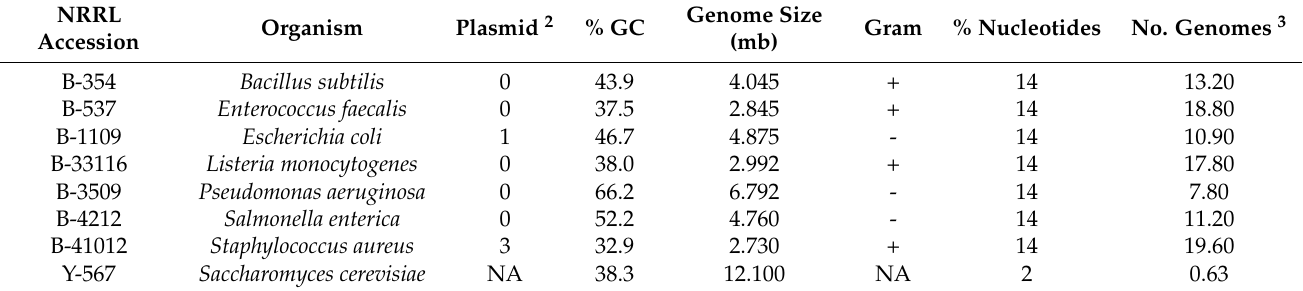
Table 1. Community members metadata for the ZymoBIOMICS DNA Standard 1